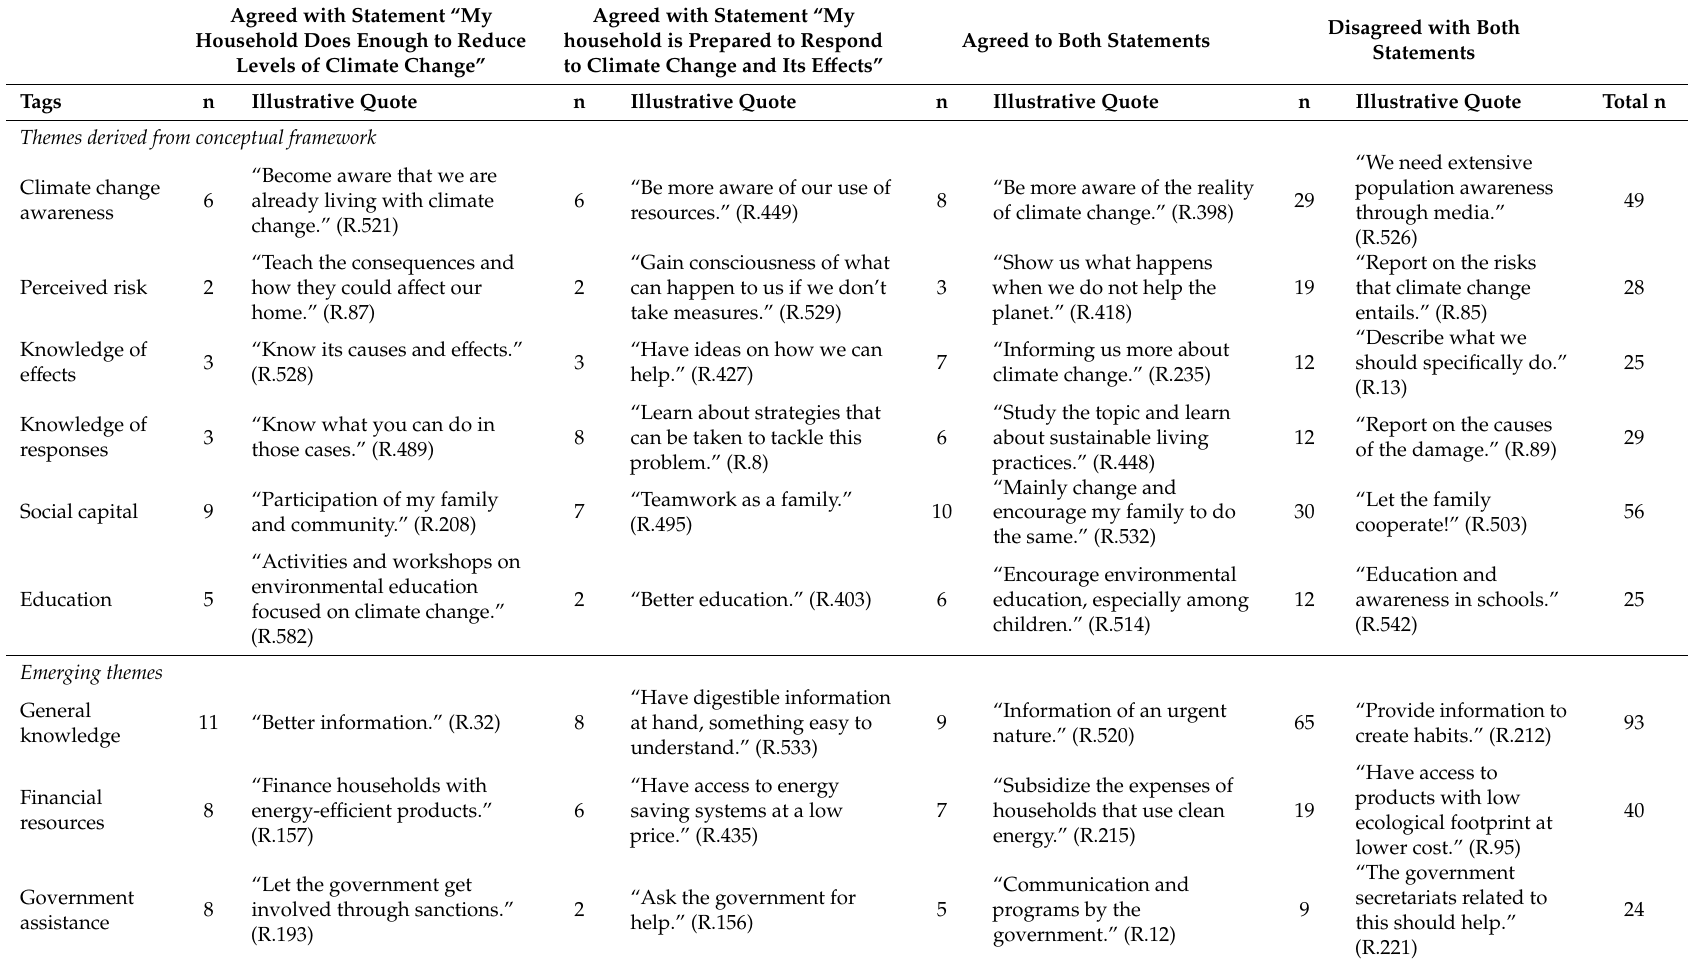
Table 4. Respondents’ perspectives regarding factors that motivate climate change action (n =